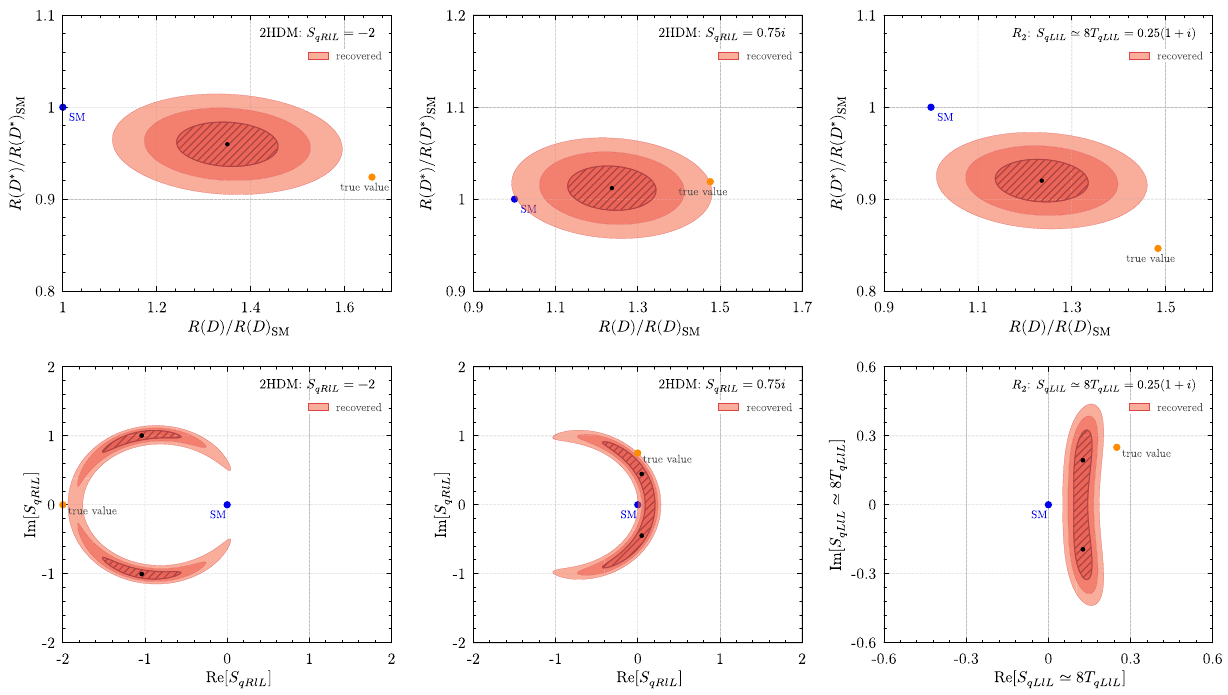
Fig. 3 Top: Illustrations of biases from fitting an SM template to three NP ‘truth’ benchmark models: the 2HDM type II with S qRlL = − 2 (left), S qRlL = 0 . 75 i (middle), and the R 2 leptoquark model with S qLlL = 8 T qLlL = 0 . 25 + 0 . 25 i (right). The orange dot corresponds to the predicted ‘true value’ of R ( D ( ∗ ) ) for the NP model, to be compared to the recovered 68%, 95% and 99% CLs of the SM fit to the NP Asi-